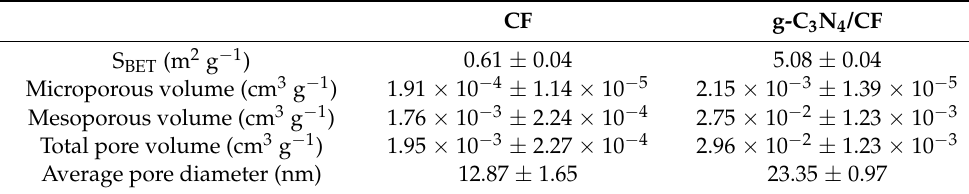
Table 1. Specific surface area, pore volume, and pore size of different